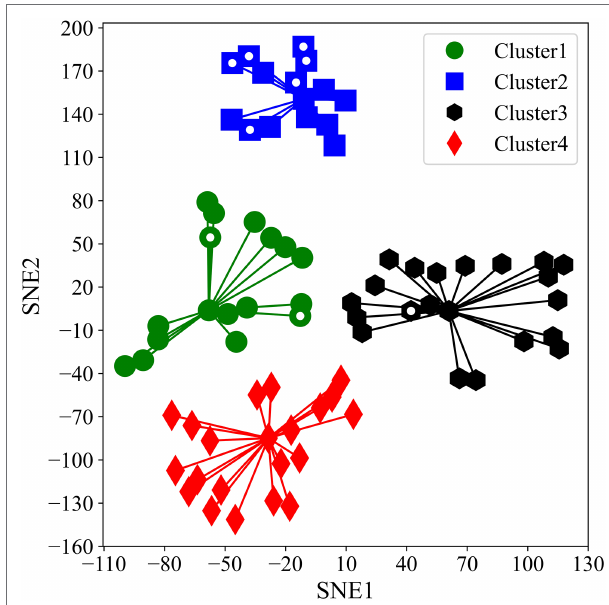
FIGURE 2 | Two-dimensional scatter plot of four different K-means clusters alongside SNE1 and SNE2. White dots inside markers indicate representative accessions we used for our second